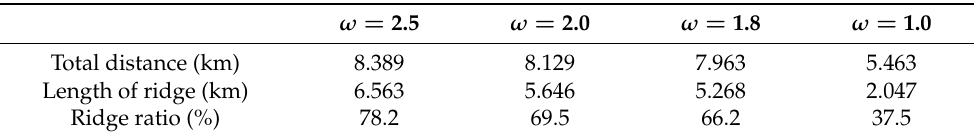
Figure 11. RA* with safety map. ( a ) Three-dimensional view. ( b ) Top view. Table 3. Data comparison of RA* with safety